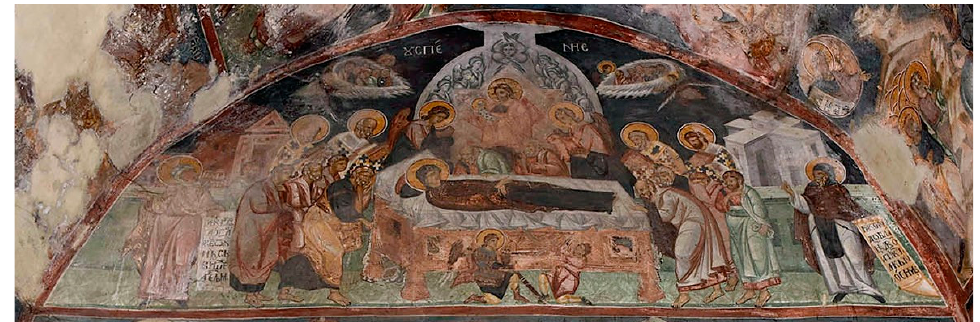
Figure 15. Dormition of the Theotokos , wall painting, 1499, Poganovo Monastery of St. John the Theologian, Serbia. (Photo credit: Ivan Vanev, The Roads of the Balkan Painters and Post-Byzantine Artistic Heritage in Bulgaria Project, http://zografi.info/, accessed on 2 February 2023).